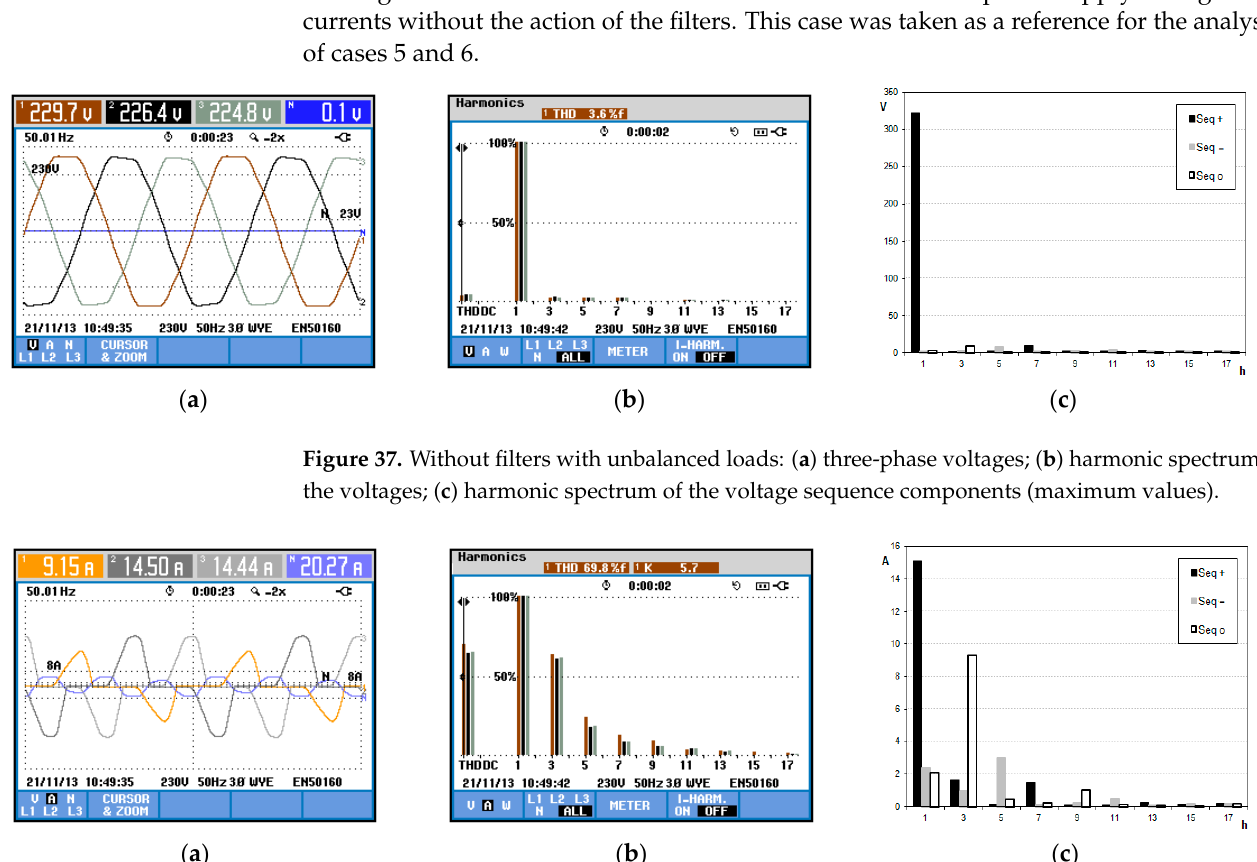
Figure 38. Case 4 - without filters with unbalanced loads: ( a ) three-phase currents; ( b ) harmonic spectrum of the currents; ( c ) harmonic spectrum of the current sequence components (maximum values).